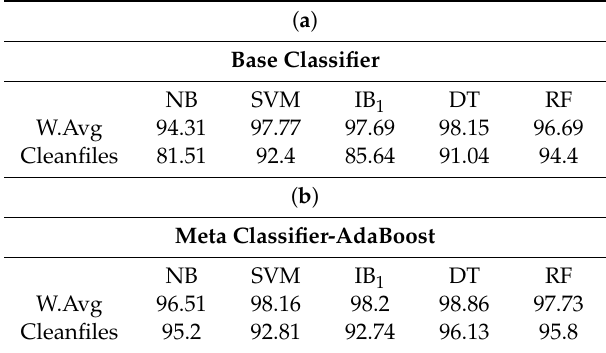
Table 5. Performance comparison when using the basic classifier and boosting technology: ( a ) Results of analysis through the basic classifier; ( b ) Analysis result using AdaBoost.